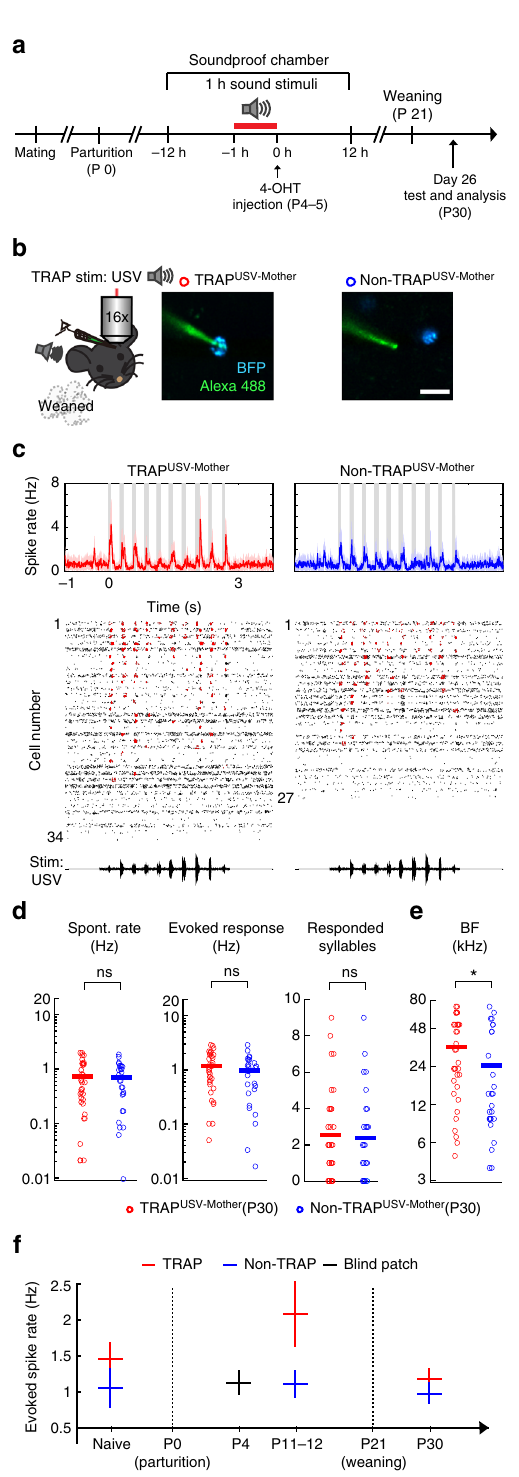
Methods Animals . All experimental procedures were approved by the Hebrew University Animal Care and Use Committee. Fos-CreER T2 (ref. 25 ) and Ai14 29 were obtained from the Jackson laboratories (Background strain C57BL/6). TB mice were gen- erated as detailed below (background strain FVB). We used the following mouse strains: Fos-CreER T2 ;TB double heterozygous female mice (F1 hybrid of C57BL/6 and FVB strain, 8 – 15 weeks old), TB heterozygous female mice (F1 hybrid of C57BL/6 and FVB strain, 9 – 10 weeks old), wild-type female mice (F1 hybrid of C57BL/6 and FVB strain, 9 – 10 weeks old) and Fos-CreER T2 ;Ai14 double hetero- zygous female mice (C57BL/6 strain, 8 – 10 weeks old).